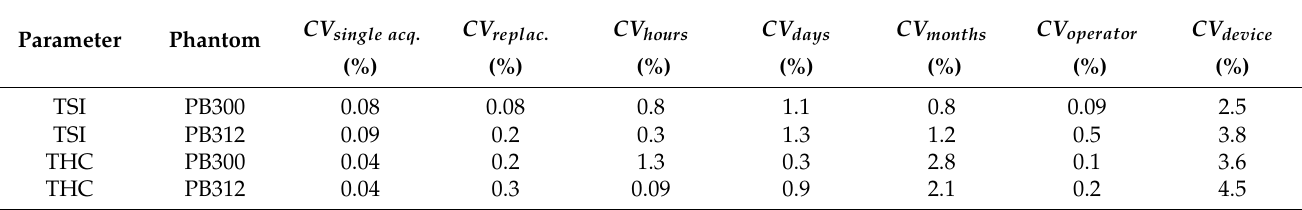
Table 2. Variability of Type 1 phantoms. Apart from the last column, which describes the inter-device variability, all the CVs reported are intra-device variabilities averaged over all the devices. See text for details. CV single acq . CV replac . Parameter Phantom